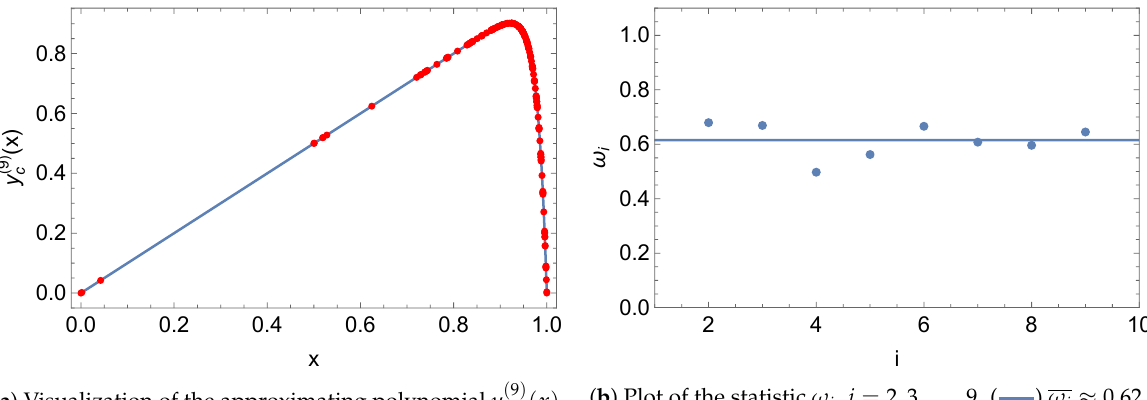
( b ) Plot of the statistic ω i , i = 2,3, . . . ,9. ( ) ω i ≈ 0.62. ( 9 ) ( x ) . A proper subset of the set of points S is shown. c